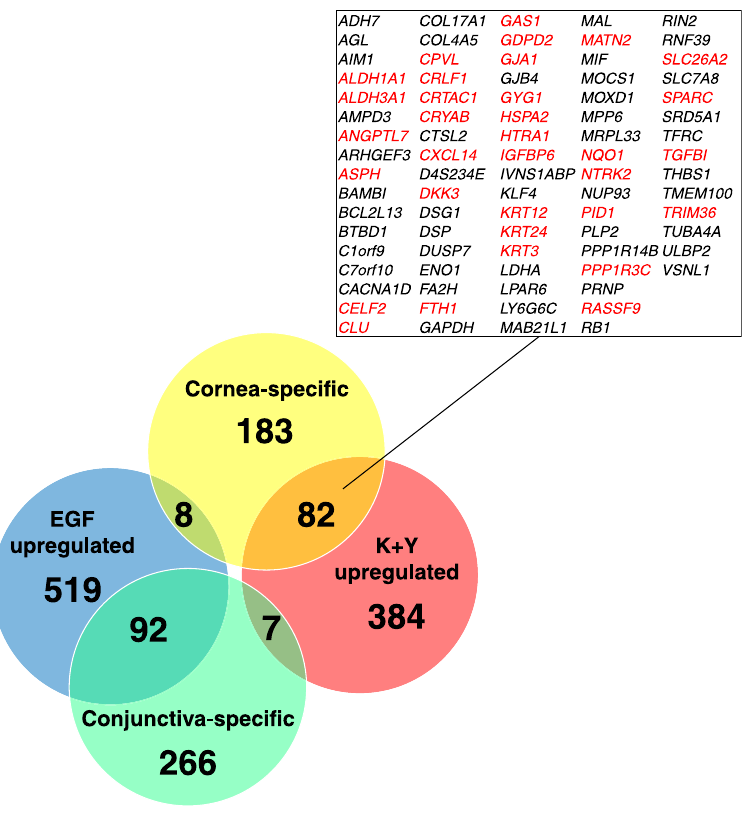
Figure 4. Venn diagram of differentially expressed genes overlapping with cornea and conjunctiva-specific genes. Genes highly expressed in LECs cultured with K + Y are shown in red, and genes highly expressed in LECs cultured with EGF are shown in blue. Genes specifically expressed in the cornea and conjunctiva based on the microarray analysis are shown in yellow and green, respectively. The 82 cornea-specific genes highly expressed in LECs cultured with K + Y are listed, and 33 of them that are considered to be regulated by PAX6 are shown in red characters. K + Y: KGF and